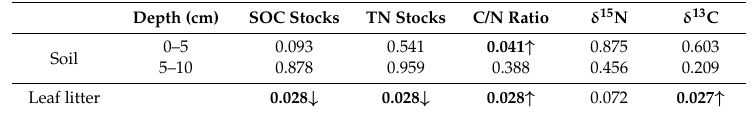
Table 2. p ‐ values as gained from the non ‐ parametric Wilcoxon Signed Rank test to identify the effect of exposure (SW vs. NW/NE) on SOC and TN stocks as well as C/N ratio and δ 15 N and δ 13 C.